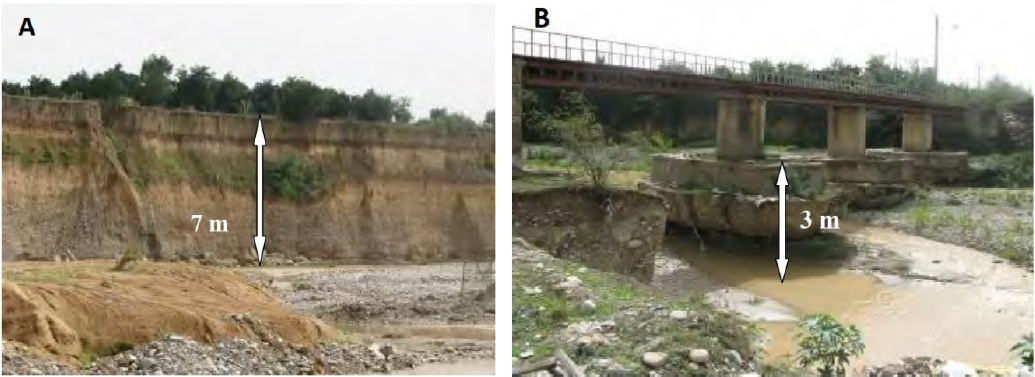
Figure 7. Channel incision due to in-stream gravel and sand mining ( A ); Effects of channel incision along the Talar River and e ff ects on bridge stability ( B ) along the Talar River and effects on bridge stability ( B ) [57].